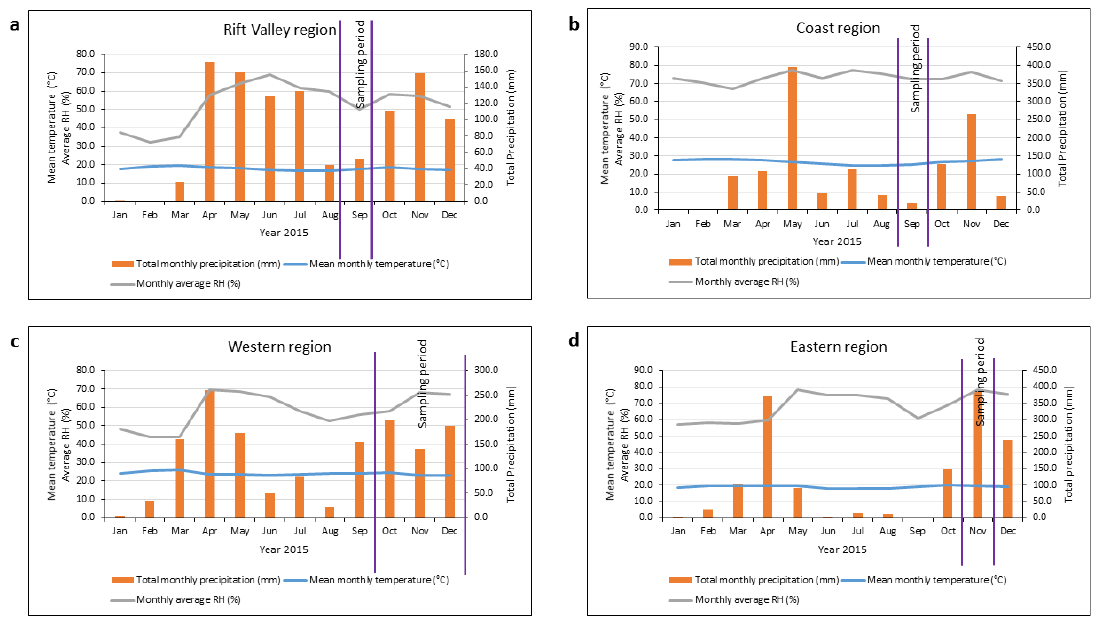
Fig. S1: Mean monthly temperature, precipitation, and relative humidity (RH) of the four regions (a) the Rift valley, (b) Coast, (C) Western, and (d) Eastern of guava fruit collection based on data from the nearest meteorological station for the year 2015. The period when sampling was carried out is indicated.